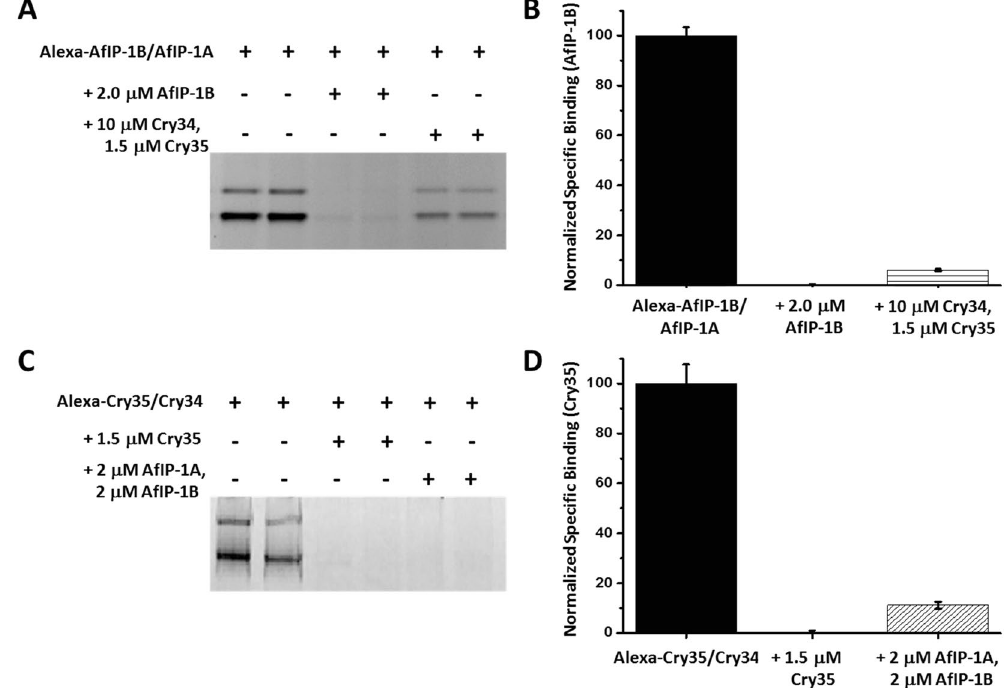
Figure 2. Shared binding sites between AfIP-1A/AfIP-1B and Cry34/35 on BBMVs from WCR midgut tissue. ( A ) Image of in-gel fluorescence after incubation of BBMVs (10 µ g) with Alexa-AfIP-1B (5 nM) with AfIP-1A (10 nM), in the absence or presence of an excess of Cry34/35 or AfIP-1B. ( C ) Image of gel representing reciprocal heterologous competition assay of Alexa-Cry35Ab1 (0.07 µ M) with Cry34Ab1 (10 µ M), in the absence or presence of an excess of Cry34/35 or AfIP-1B. Normalized specific binding of AfIP-1B ( B ) and Cry35Ab1 ( D ) based on optical densitometry of gel images represented in ( A ) and ( C ) after subtraction of nonspecific binding (see Supplementary Information). The data presented are the average and SEM of 3 experiments consisting of 2 or 3 determinations each.